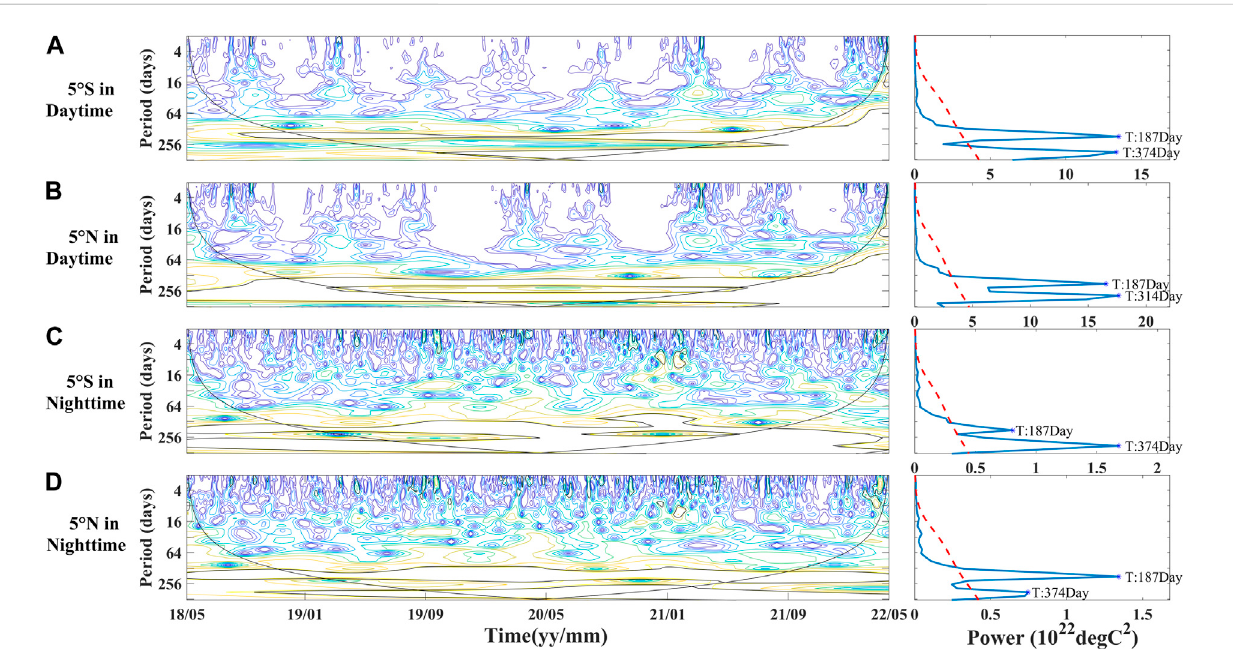
FIGURE 7 The Spectral analysis results using Morlet wavelet analysis for Ne during ±5 ° Mlat at daytime SH (A) , NH (B) and at nighttime in SH (C) , NH (D) , respectively. The left columns show the Wavelet Power Spectrum results, while the right columns show the results of Global Wavelet Spectrum (GWS), and the dashed red lines are the 95% con fi dence